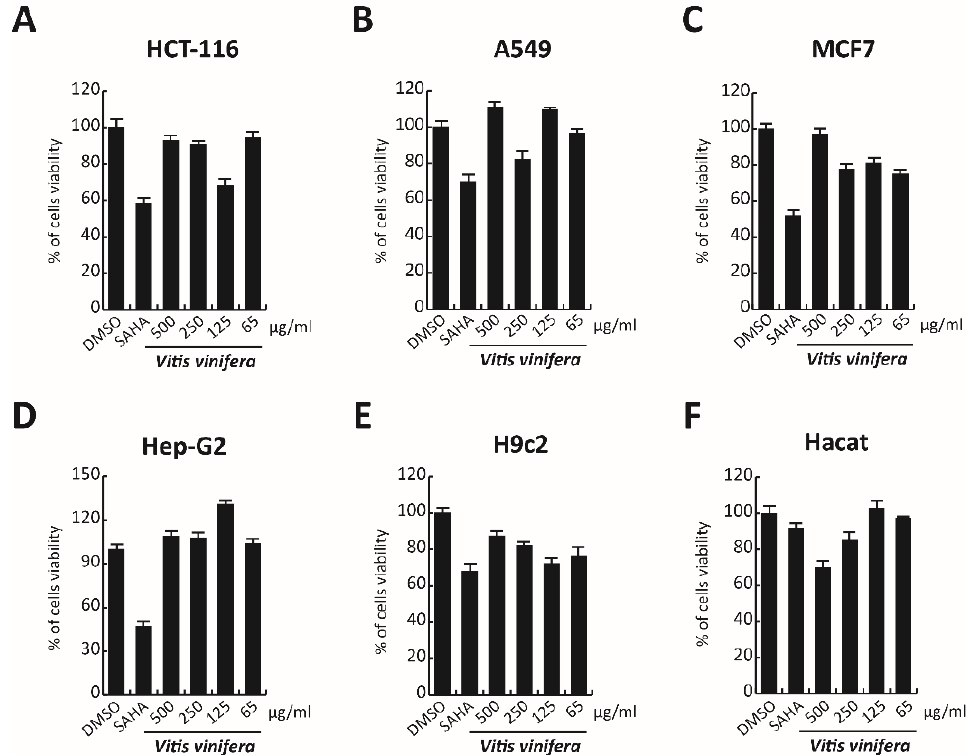
Figure 9. ( A – F ) Cell viability evaluation by MTT assay of HCT-116, A549, MCF7, cardiomyocytes, Hep-G2, and Hacat cells after treatment with V. vinifera for 48 h at 500, 250, 125, and 65 µg/mL. SAHA was used as a control at 5 µM for 24 h.